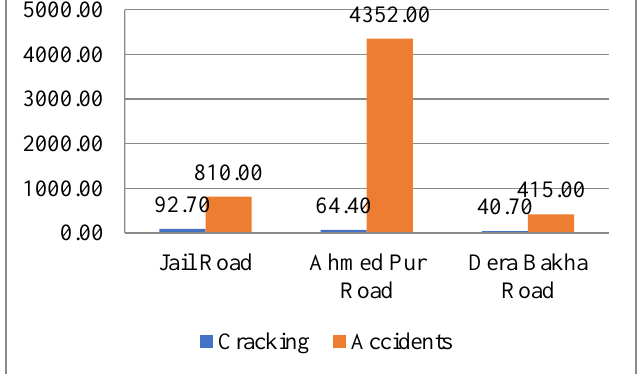
Fig. 14. Comparison of PCR and accident data